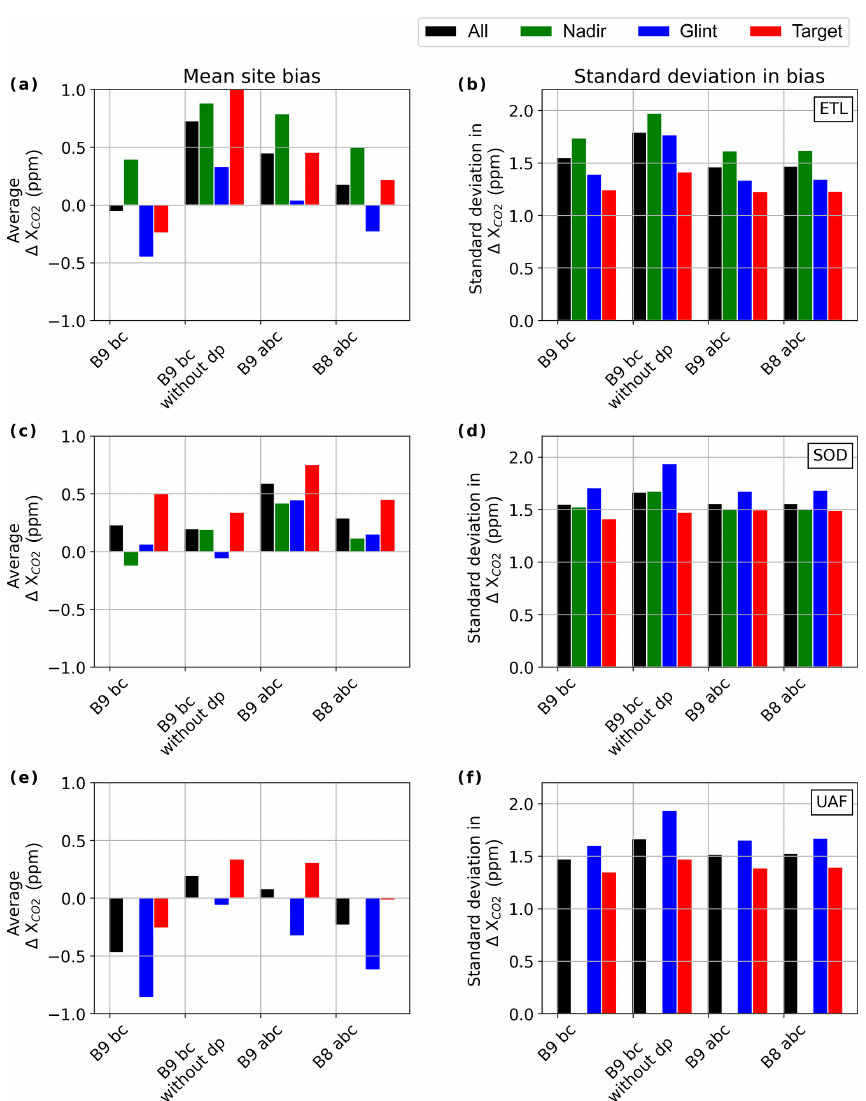
Figure 16. Average bias and standard deviation in bias sorted by viewing geometry and bias correction modification for all coincident soundings at each of the three boreal forest sites with boreal QC. Note that there are no coincident nadir soundings for Fairbanks due to the satellite’s operational design which favors glint observations in orbits primarily over